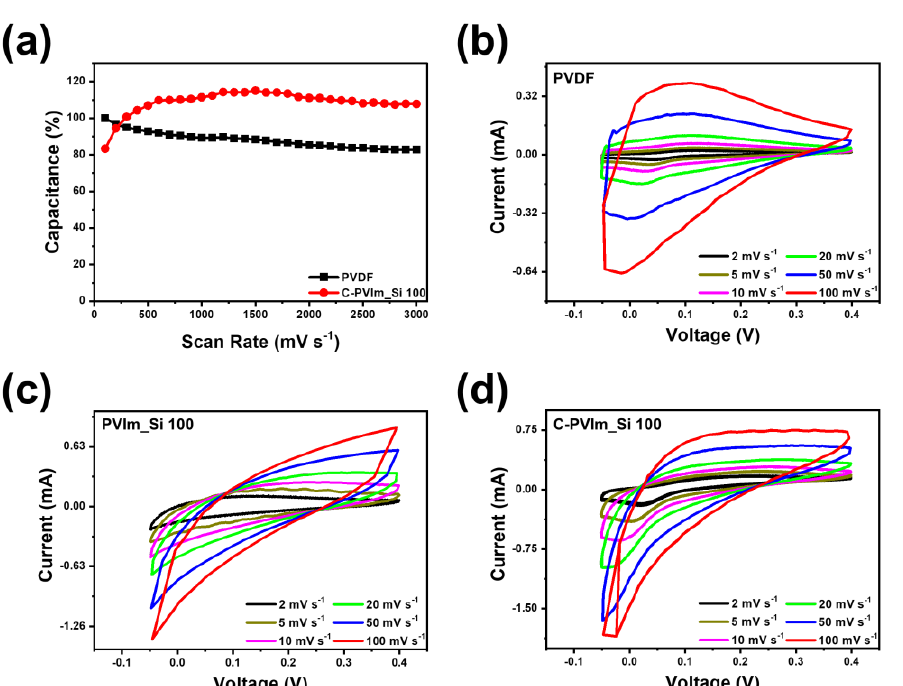
Figure 7. Schematic illustration of working electrode.